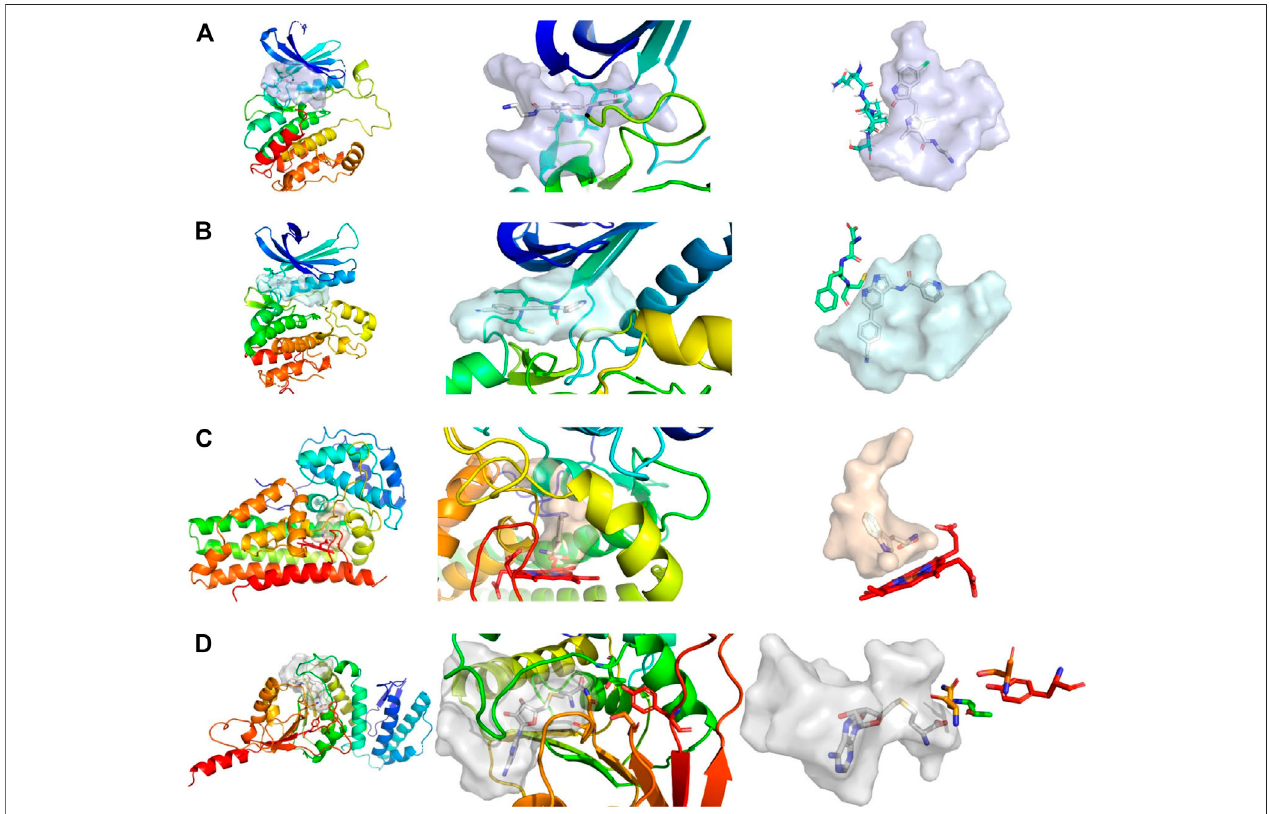
FIGURE1| Comparisonofactivesites,fromlefttoright,showsthecompleteprotein,aclose-upviewofthepocket,andtheshapeofthepocketwithcharacteristic residues explicitly depicted. (A) Structure of CAMK1G (PDB entry 2JAM), where residues of the hinge region are shown. (B) Structure of AAK1 (PDB entry 5L4Q) with residues shown that are part of the hinge region. (C) Structure of IDO1 (PDB entry 6E46) shown with the JK-(gate)-loop colored in red in the middle. The heme cofactor and tryptophan are depicted as a reference. (D) Structure of DOT1L (PDB entry 3QOX), where the residues depicted are vital for methylation of the lysine. S-Adenosylhomocysteineisdepictedinthepocket. Thekinasepockets arethemostvoluminous,followedbyDOT1L andIDO1. TheIDO1pocket isthemostenclosed pocket, which changes depending on the heme binding state from the JK-loop. Surfaces were created by fi lling the binding site with a 1 Å spaced grid and by deleting